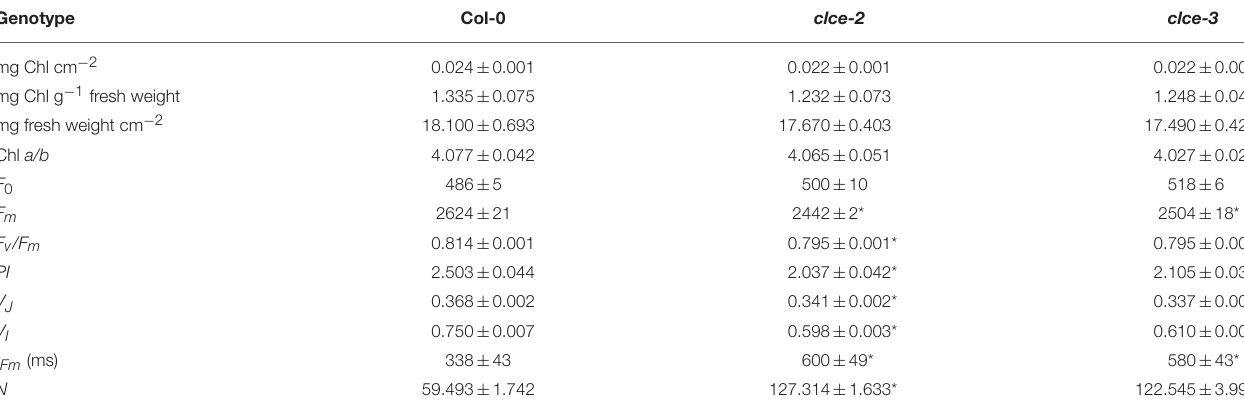
TABLE 1 | Chlorophyll (Chl) content and photosynthetic performance of dark-adapted plants. Genotype